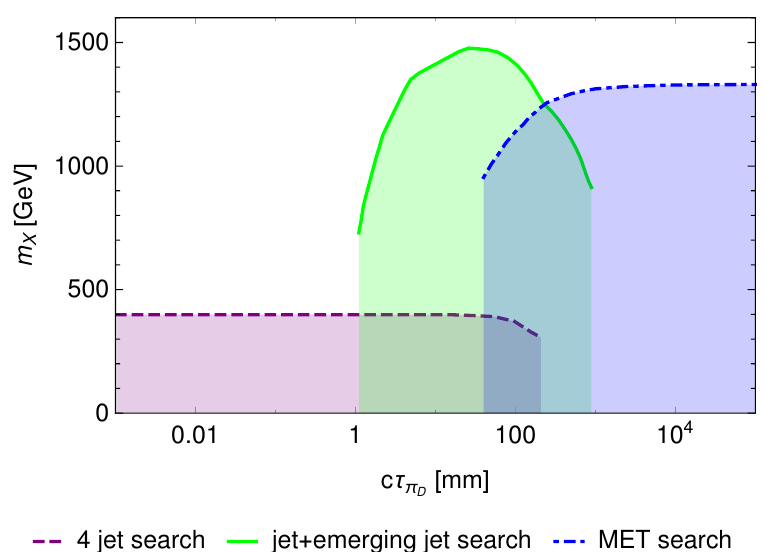
Figure 6. Constraints on the mediator mass for the three searches: (i) in dashed purple: 4 jets search, (ii) in solid green: emerging jets search, (iii) in dot-dashed blue: MET search. The coloured areas are excluded by the respective